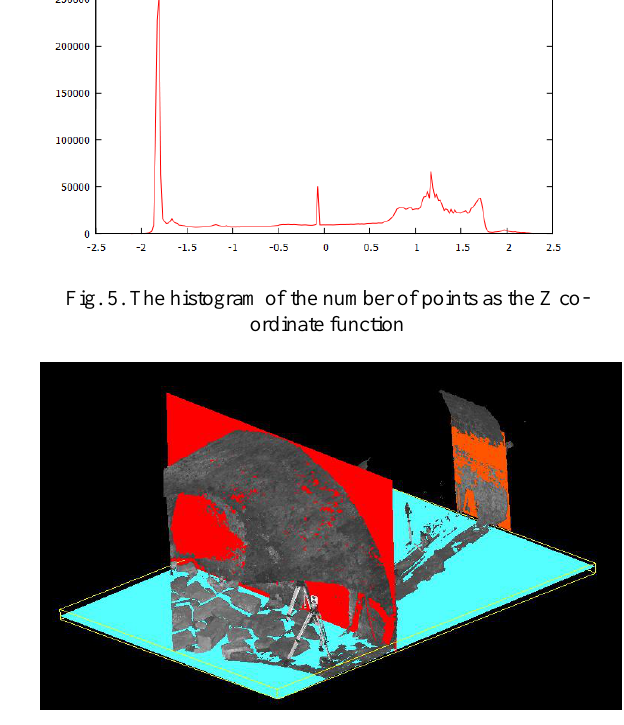
Fig. 6. Planes detected by own algorithm (vertical in red and orange, blue – for the vertical plane It was assumed during calculations that the maximum distance of points to the theoretical plane equals to 50 mm. Considering that the wall is constructed of irregular bricks, the distribution of deviations does not correspond to Gaussian distribution (Fig. 7).